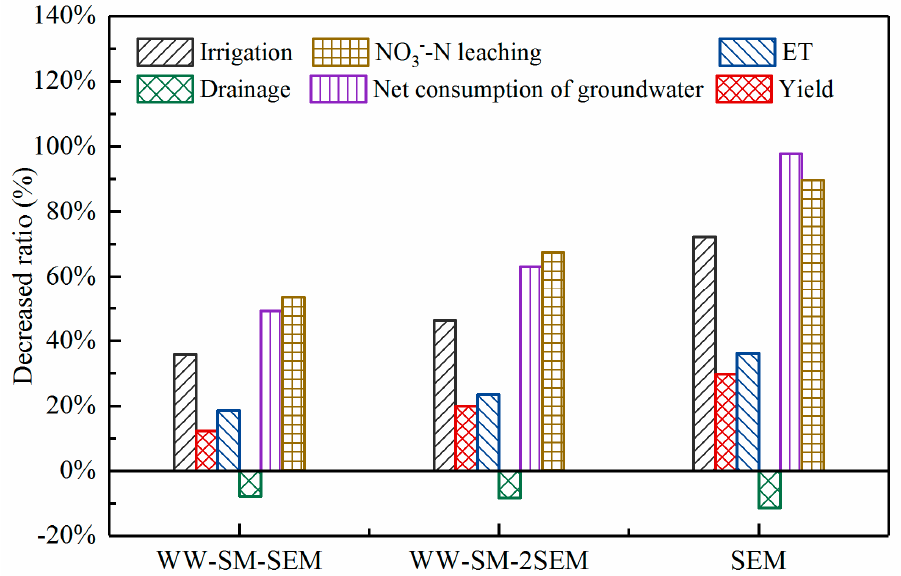
Figure 7. The decreased ratio of yield, evapotranspiration (ET), drainage, irrigation, net consumption of groundwater, and NO 3 − -N leaching of the three alternative cropping systems (WW-SM-SEM, WW-SM-2SEM, and SEM), compared with the local rotation system (WW-SM_ai). WW-SM-SEM, WW-SM-2SEM, and SEM are the winter wheat–summer maize and fallow–early maize system, with three harvests in two years; the winter wheat–summer maize and double fallow–early maize system, with four harvests in three years; and the single early maize system with one harvest per year.